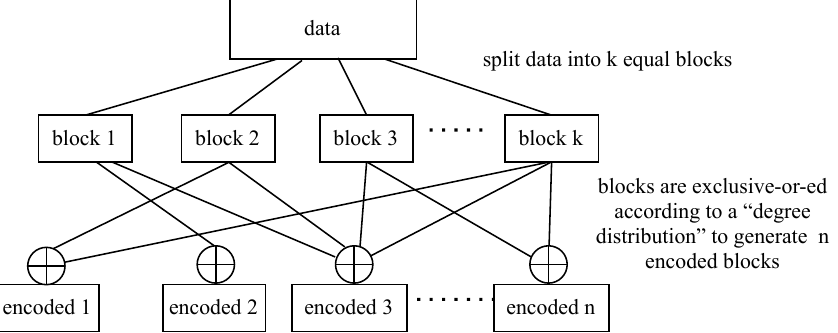
Figure 1. Schematic diagram of an ( n , k ) fountain code. The blocks are encoded into n encoded blocks using a given degree